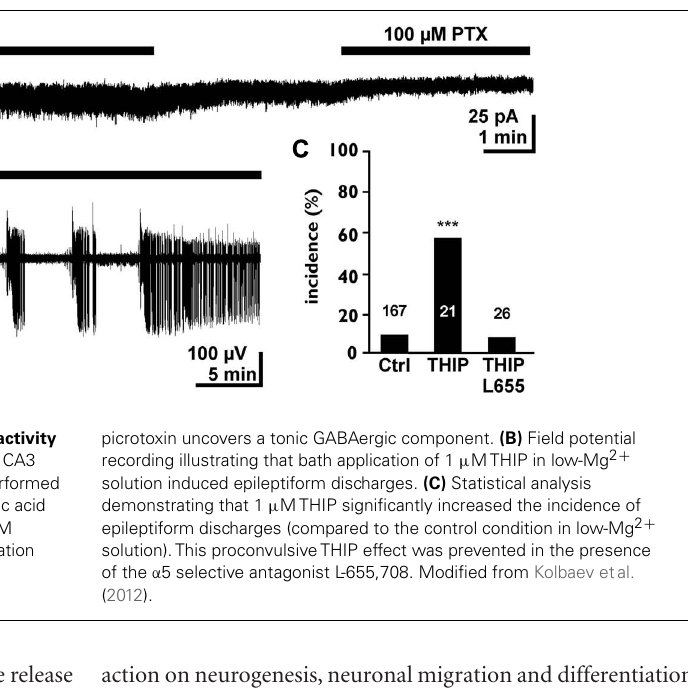
picrotoxin uncovers a tonic GABAergic component. (B) Field potential recording illustrating that bath application of 1 μ MTHIP in low-Mg 2 + solution induced epileptiform discharges. (C) Statistical analysis demonstrating that 1 μ MTHIP significantly increased the incidence of epileptiform discharges (compared to the control condition in low-Mg 2 + solution).This proconvulsiveTHIP effect was prevented in the presence of the α 5 selective antagonist L-655,708. Modified from Kolbaev etal.